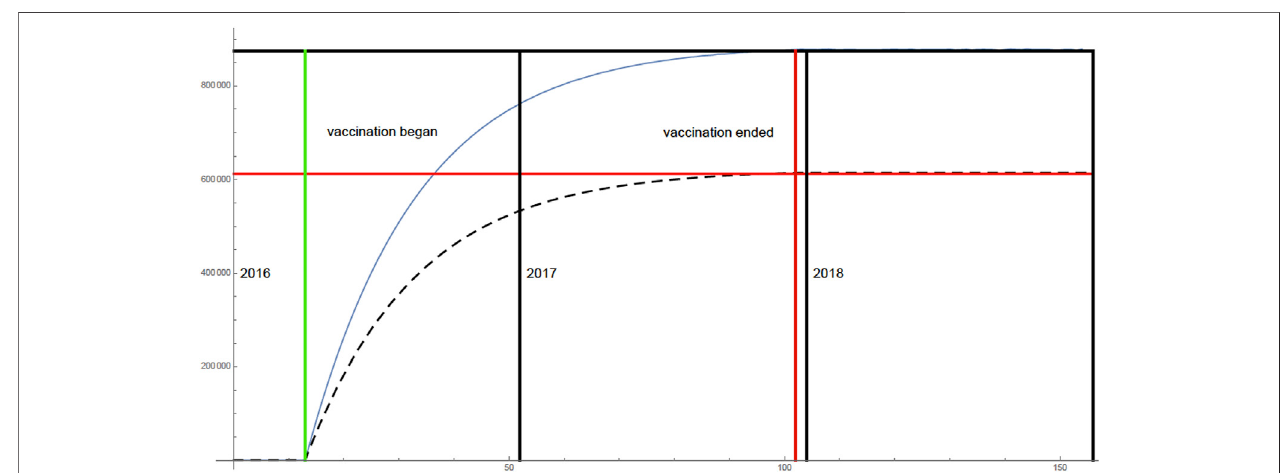
FIGURE4| All875,0009 yearsoldsarevaccinated.Thecumulativenumberofvaccinated9 yearsolds (topgraph) .Attheendofthevaccinationprogram,70%of the 875,000 of the children vaccinated (612,500) were vaccine-effective (bottom graph) .